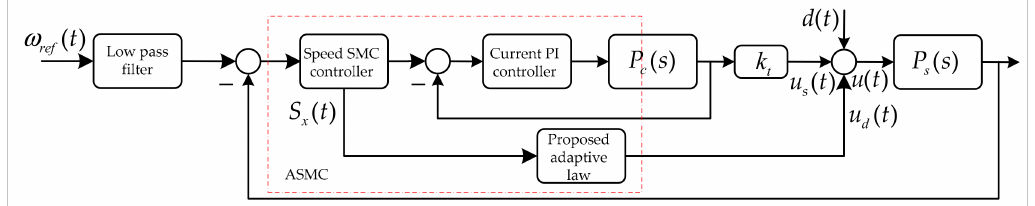
Figure 4. Simulation control diagram of the proposed control